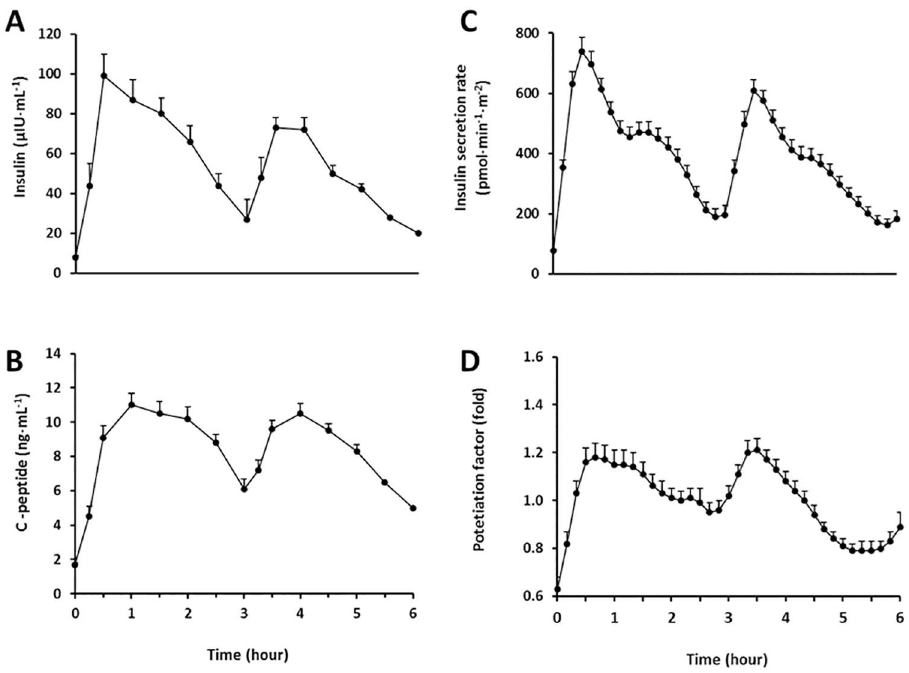
Fig 2. Serum insulin and C-peptide concentrations before and after two consecutive 75-g oral glucose loads. Glucose loads were given at time 0 and 3 h. Mean ±